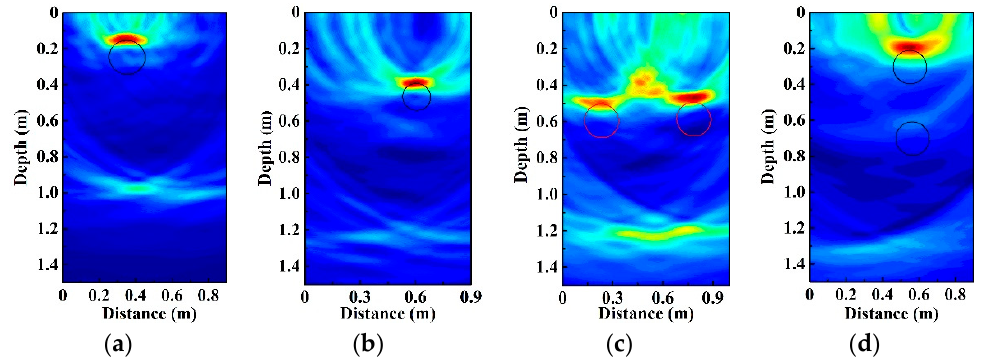
Figure 5. The radar profile of buried plastic pipes. ( a ) The position of plastic pipe 1 is at (0.35, 0.15) m. ( b ) The position of plastic pipe 2 is at (0.60, 0.38) m. ( c ) The positions of two plastic pipes 1 are at (0.22, 0.50) m and (0.76, 0.50) m. ( d ) The positions of two plastic pipes 1 are at (0.55, 0.20) m and (0.55,